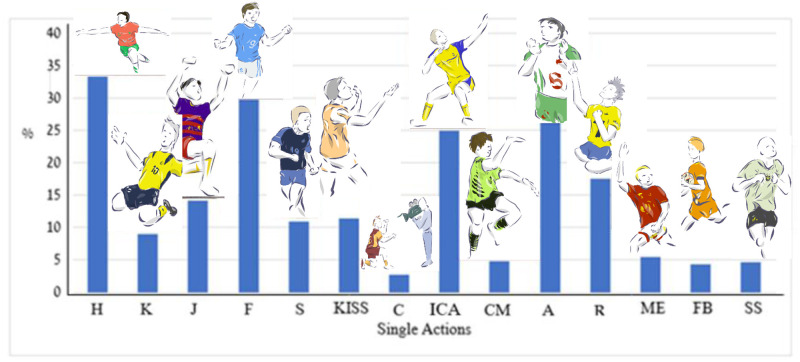
Percent of single player’s acts (K = 14; # of actions = 731) in 366 goal celebrations.Index: H–Outstretched hands; K–Glitch; J–Air jump; F–Hand fist; S–Vocal scream; KISS–Emotion expression (kissing/heart); C–Approaching camera; ICA–Pre-determined movement; CM–Spontaneous movement; A–Appealing to audience; R–Religious virtue; ME–Self-aggrandizement; FB–Ball catching; SS–Tapping shirt symbol.